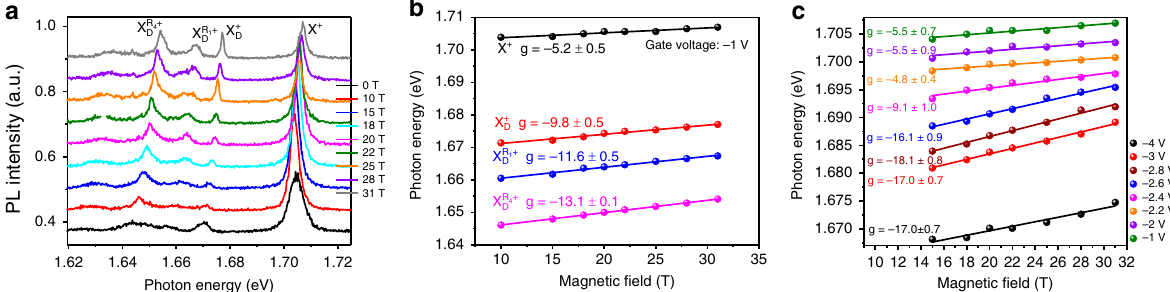
Fig. 4 Valley-Zeeman shift from the magneto-PL spectra. a PL spectra in the σ − σ − con fi guration at the gate voltage of − 1V for various magnetic fi eld strengths. b The extracted PL peak position (solid dots) of X + , X þ Solid lines are the linear fi ttings, with the extracted g-factor labeled. c The extracted g-factors of the bright positive trion X + for different gate